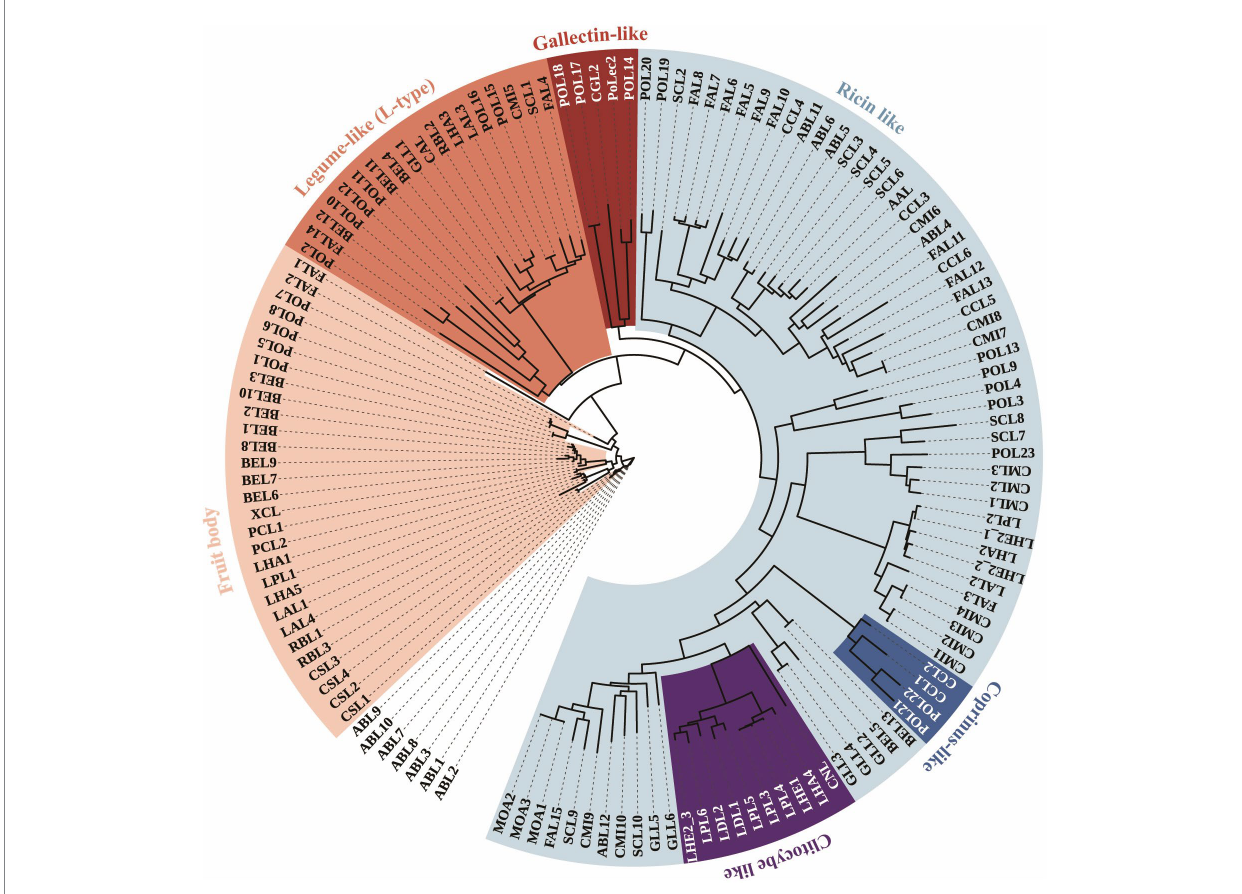
FIGURE 1 Phylogenetic tree of 137 lectin proteins from 22 species in Agaricomycetes. Unrooted phylogenetic tree of lectins protein sequences from Pleurotus ostreatus (POL1-23 and PoLec2), P. cornucopiae (PCL1 and PCL2), Agaricus bisporus (ABL1-8), Auriculariopsis ampla (AAL), Clitocybe nebularis (CNL), Coprinellus micaceus (CML1-10), C. cinerea (CCL1-6), Cubamyces menziesii (CML1-3), Cyathus striatus (CSL1-4), Flammula alnicola (FAL1-15), Schizophyllum commune (SCL1-10), Boletus edulis (BEL1-13), Xerocomellus chrysenteron (XCL), Cantharellus anzutake (CAL), Ganoderma leucocontextum (GLL1-6), Lactarius akahatsu (LAL1-4), L. deliciosus (LDL1 and LDL2), L. hatsudake (LHA1-5), L. hengduanensis (LHE1 and LHE2_1- LHE2_3), L. pseudohatsudake (LPL1-6), Macrolepiota procera (MOA1 and MOA2), and Russula brevipes (RBL1-3). The outer ring indicates the classes of lectins, including Galectins (shaded in red), Coprinus-like (shaded in blue), Ricin-like (shaded in cyan), Clitocybe-like (shaded in purple), Legume-like (shaded in orange), and Fungal fruit body (shaded in pink) lectins. The tree is displayed using the iTOL web